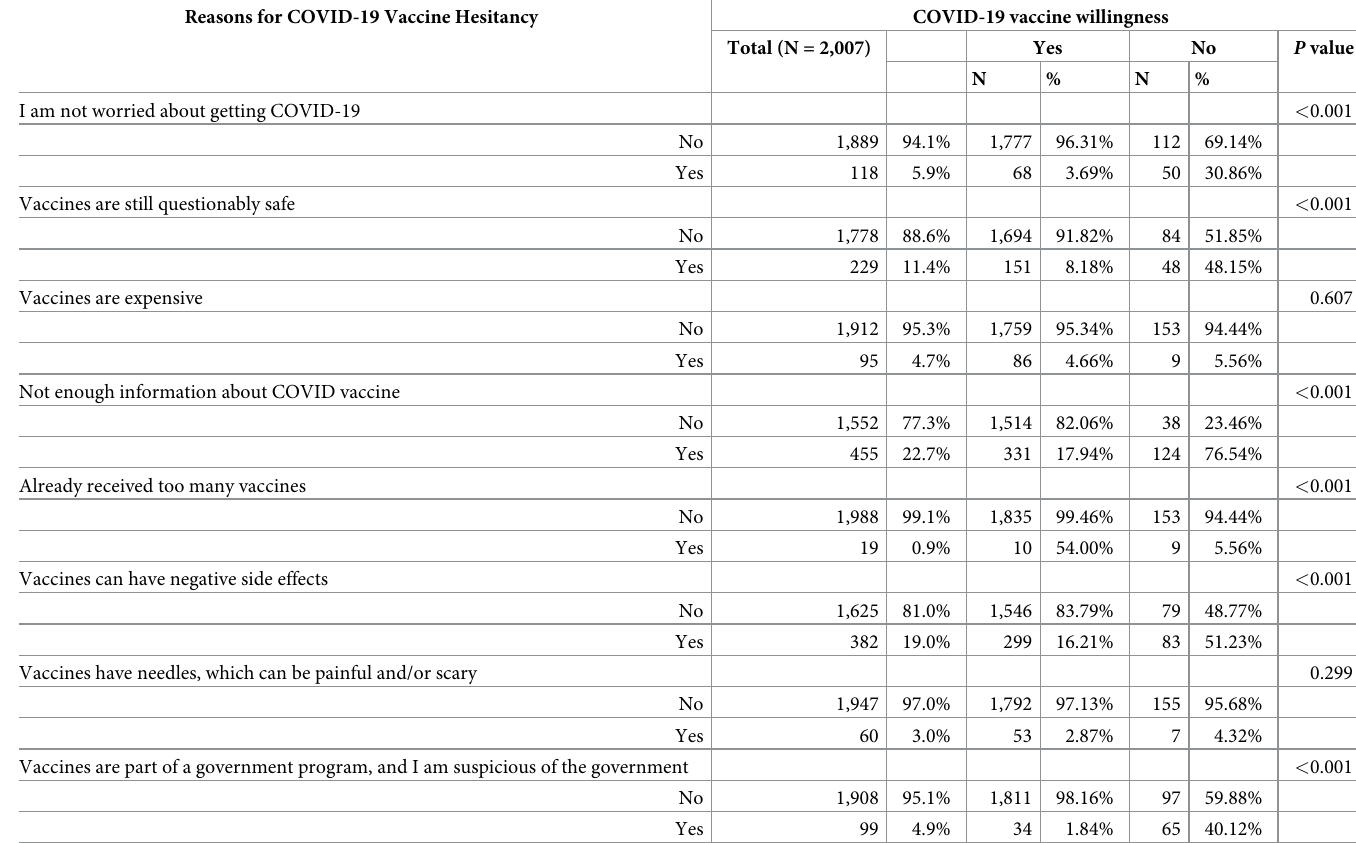
Table 3. Reasons for COVID-19 vaccination